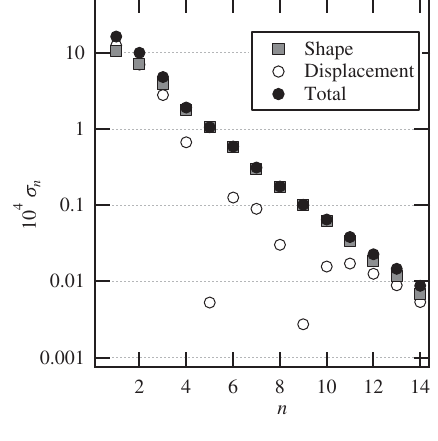
FIG. 13. Standard deviation of the multipoles σ σ ð a σ ð b = 2 , expressed at 7 mm. The tolerances n ¼ ½ n Þ þ n Þ(cid:4) are (cid:3) 0 . 020 mm for the shape tolerances, (cid:3) 0 . 020 mm for the pole displacements and (cid:3) 0 . 040 mm for the complete magnet.